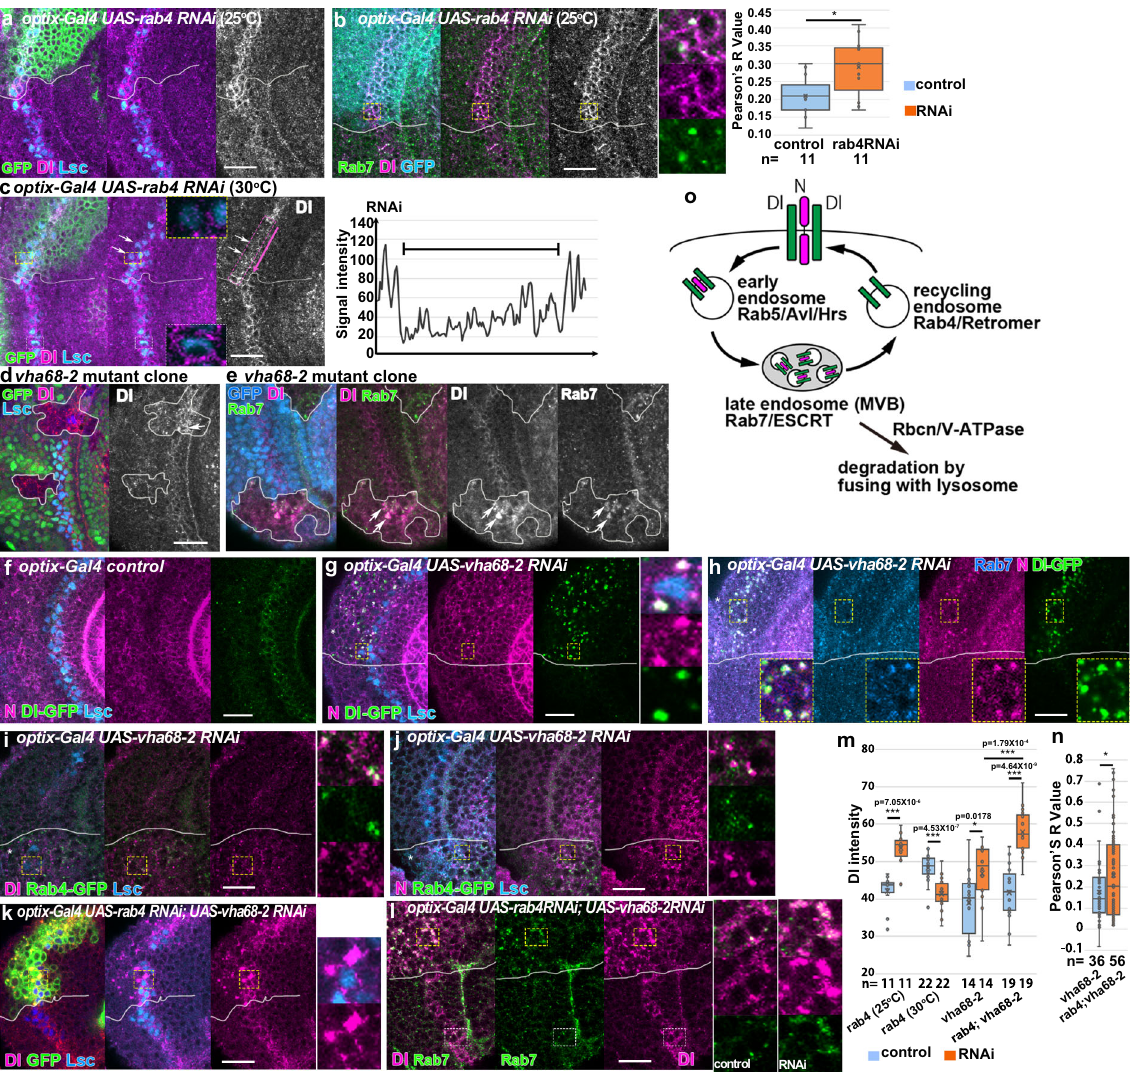
Fig. 6 Delta transport from late endosomes to recycling endosomes. a , b Dl aggregation (magenta or white) upon rab4 RNAi ( optix-Gal4 , green in a , blue in b ) at 25 °C. Lsc, blue ( a ) and Rab7, green ( b ). Dl colocalizes with Rab7 ( b ). The white dotted box is magni fi ed. The colocalization of Dl with Rab7 is quanti fi ed ( p = 0.016 (* p < 0.05), two-sided t test). c Loss of Dl expression (arrows) by rab4 RNAi ( optix-Gal4 , green) at 30 °C at the wavefront (Lsc, blue). The white dotted boxes are enlarged showing the decrease of Dl in the mutant area (yellow) compared with the control area (white). Signals in the magenta dotted box are plotted in the right panel. The magenta arrow indicates the orientation along the x -axis. d , e Dl is upregulated in vha68-2 mutant clones (arrows) visualized by the absence of GFP (green in d , blue in e ) at the wavefront (Lsc, blue in a ). Ectopic Dl is accumulated in Rab7-positive structures (green in e ). f Control distributions of N (magenta), Dl-GFP (green), and Lsc (blue). g – j vha68-2 RNAi under the control of optix-Gal4 . Distribution of ectopic N puncta (magenta in g – j ), Dl-GFP (green in g , h ), Dl (magenta in i ), Rab7 (blue in h ), and Rab4-GFP (green in i , j ) is compared behind the wavefront (Lsc, blue in g , i , j ). k , l rab4 vha68-2 double RNAi under the control of optix-Gal4 (GFP, green in k ). Dl (magenta), Rab7 (green in l ), and Lsc (blue in k ). The yellow and white dotted boxes in RNAi and control areas, respectively, are magni fi ed in the right panels. Asterisks indicate the optix-Gal4 -positive areas outlined by white lines. m Dl intensity quanti fi cation in different RNAi conditions ( p values are indicated inside the panel, * p < 0.05, *** p < 0.001, two-sided t test). n Quanti fi cation of the colocalization between Dl and Rab7 ( p = 0.041 (* p < 0.05), two-sided t test). b , m , n Numbers of quanti fi ed areas are indicated. Cross, mean; center line, median; box limits, upper and lower quartiles; whiskers, 1.5× interquartile range in the box plots. o Putative intracellular mechanisms that degrade N and recycle Dl. Scale bars, 20 μ